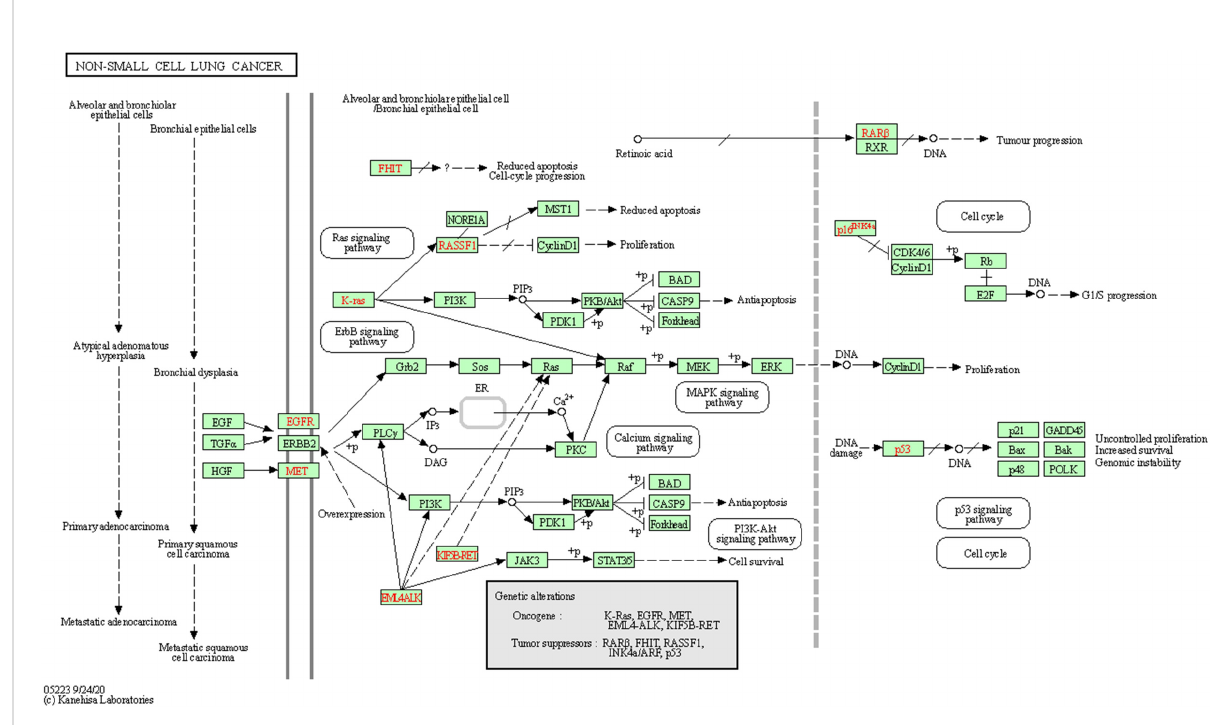
FIGURE 4 Map of gene pathways associated with non-small cell lung cancer. The red rectangular nodes represent the associated genes in 196 drug- disease overlapping genes.